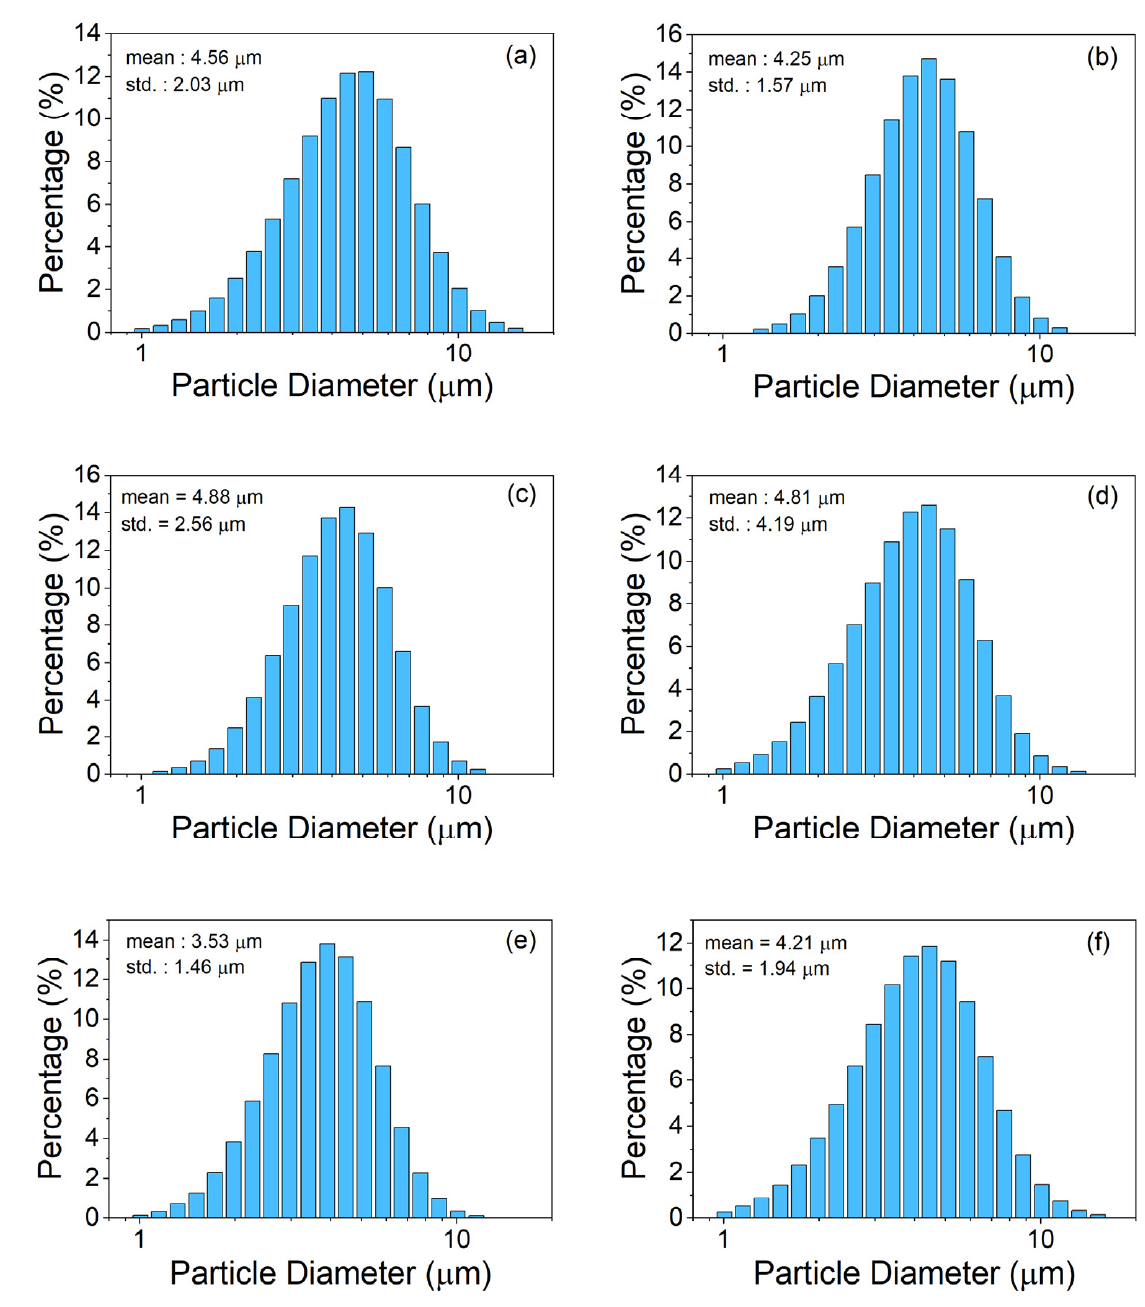
Figure 2. Particle size distribution for milled MCM powders ( a ) P-1 M, ( b ) P-2 M, ( c ) P-3 M, ( d ) P-4 M, ( e ) P-5 M, and ( f ) P-6